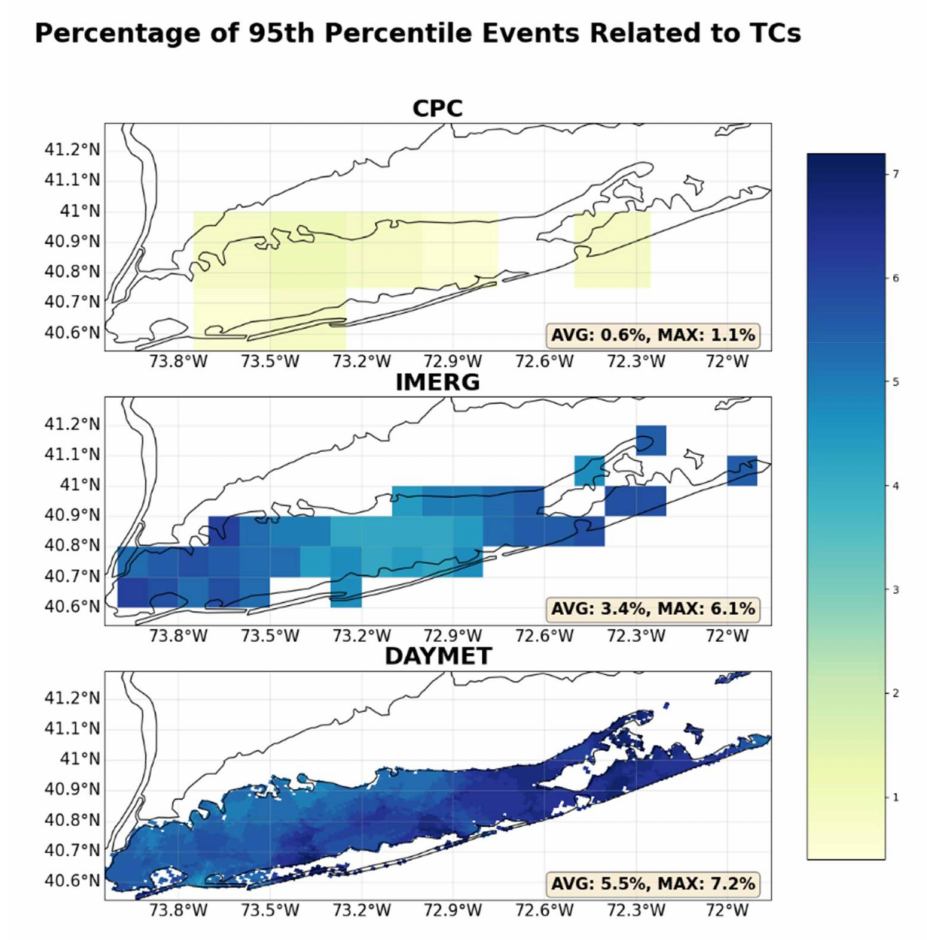
Figure 4. The percentage of 95th-percentile precipitation events due to TCs for the common time period (2001–2020) for ( top ) CPC, ( middle ) IMERG, and ( bottom )